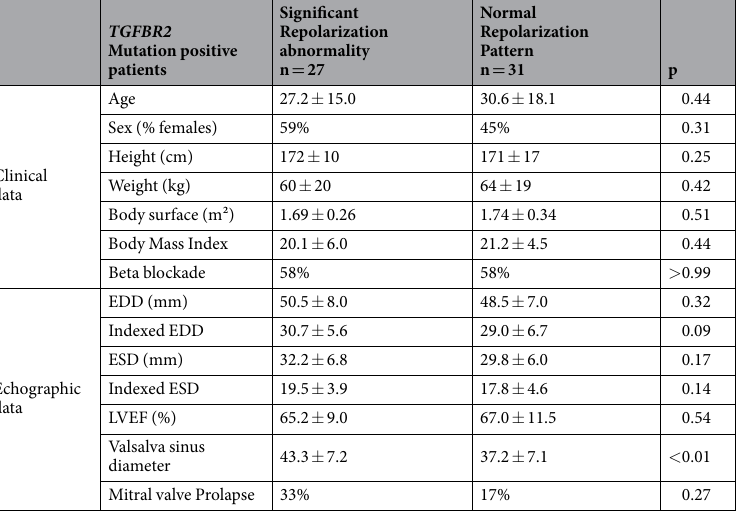
Table 2. Clinical and echocardiographic data in TGF β R2 mutation carriers with or without significant ventricular repolarization